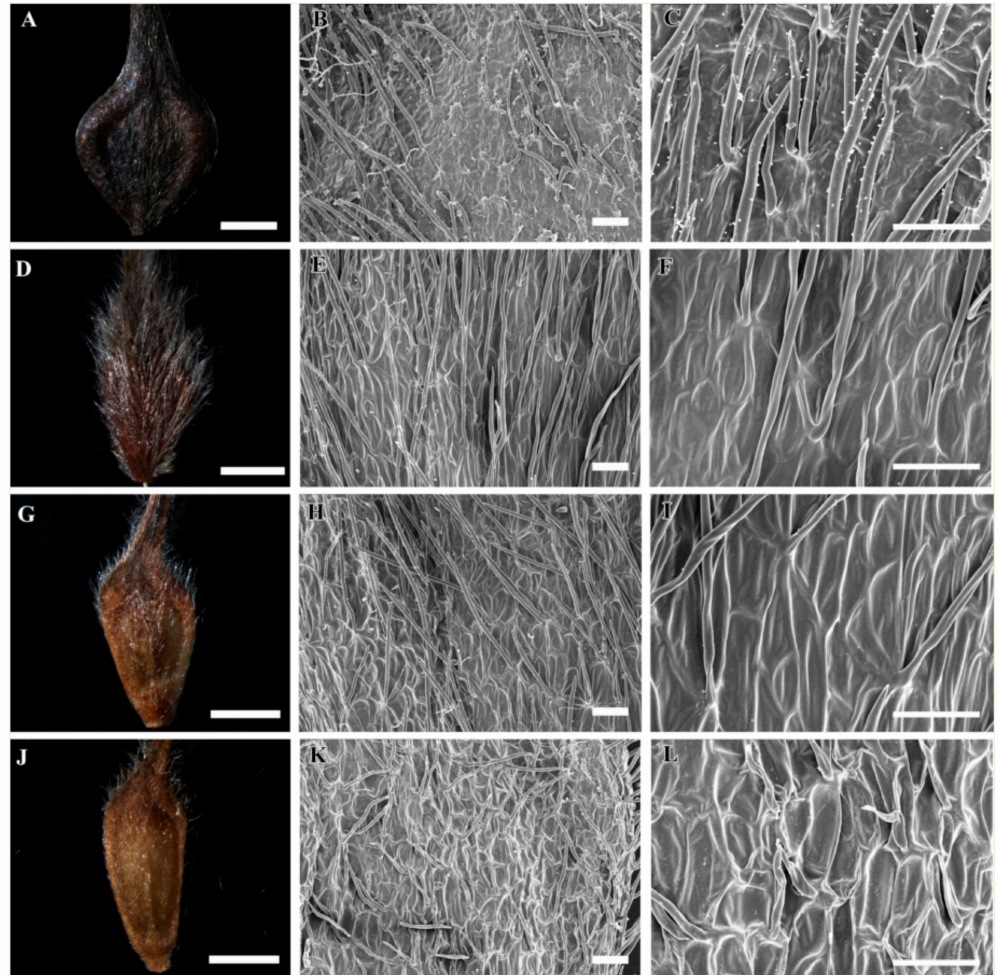
Figure 4. Stereomicroscopic and scanning electron microscopic micrographs of achenes of Clematis